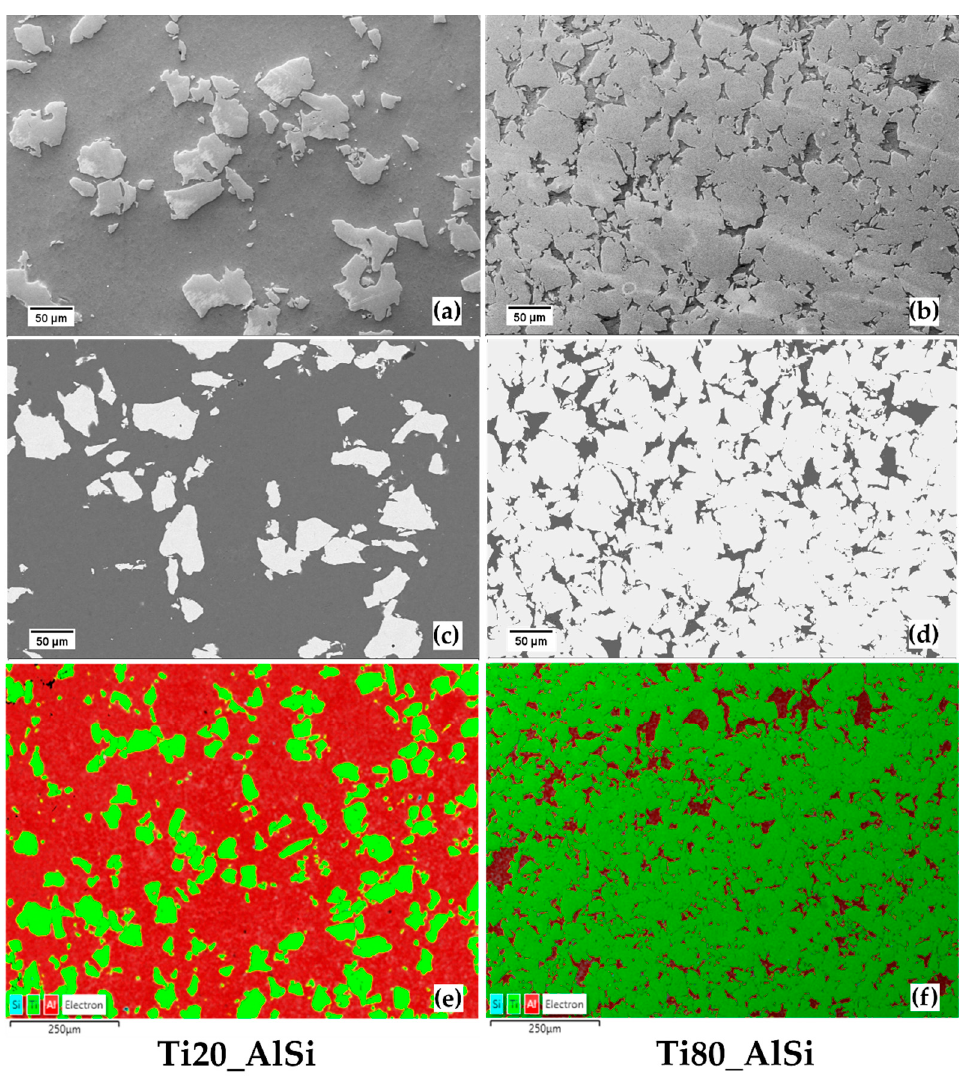
Figure 4. SEM micrograph of the samples ESFed at high energy. ( a , b ) are secondary electron SEM images, ( c , d ) are back-scattered electrons (BSE) images, and ( e , f ) are EDS maps at low magnification.